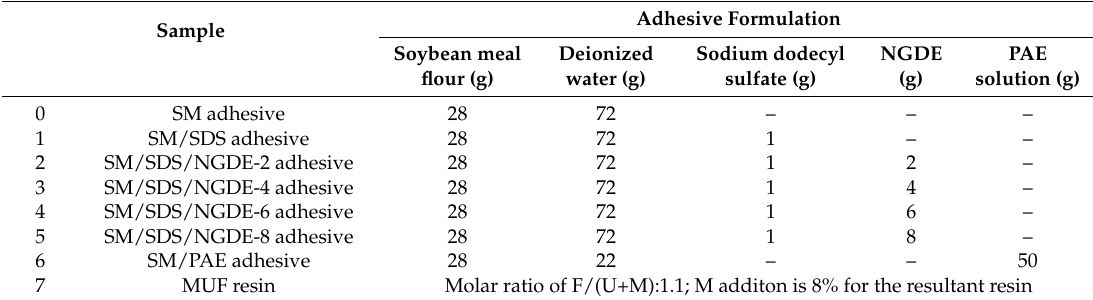
Table 1. Various adhesive formulations.